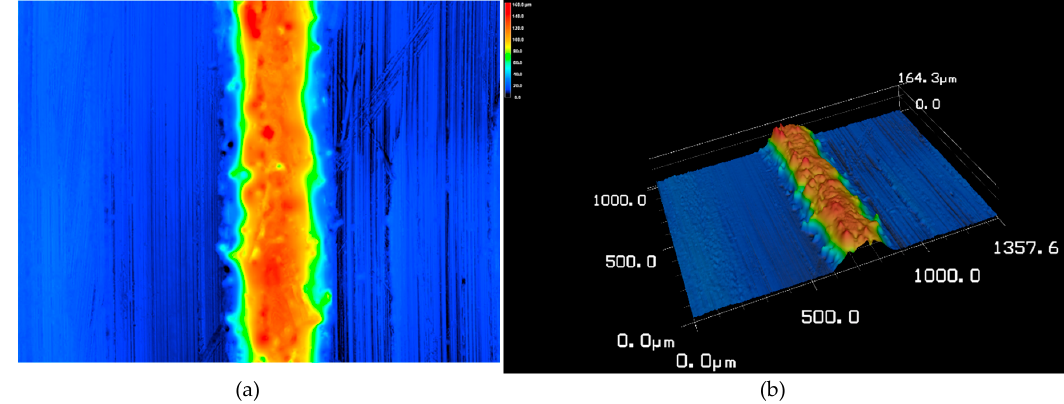
Figure 5. Comparison of maximum FEA temperature that is averaged over a camera pixel and IR data of Ti-64 sample at 400 W and 200 to 1100 mm/s . Figure 6. ( a ) Two-dimensional and ( b ) three-dimensional confocal microscopy images of single beads Ti-64 samples produced at laser power of 400 W at scanning speed of 200 mm/s.